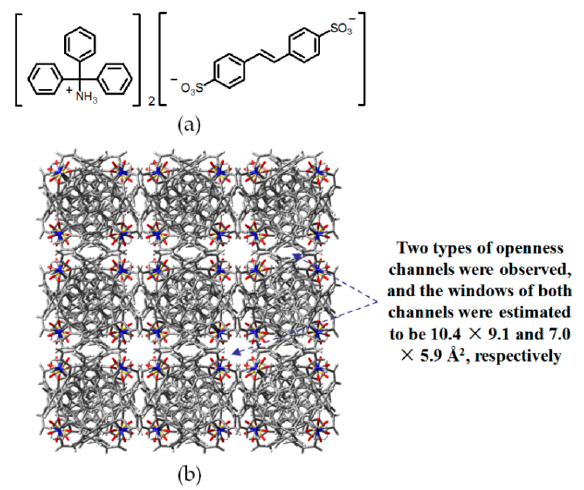
Figure 33. ( a ) Organic salt building motif of H37 ; ( b ) Crystalline porous network of H37 .